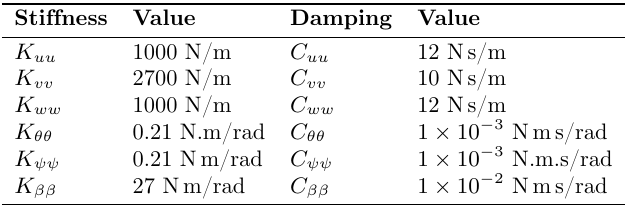
Table 2. Motor-shaft coupling characteristics of the rotor test